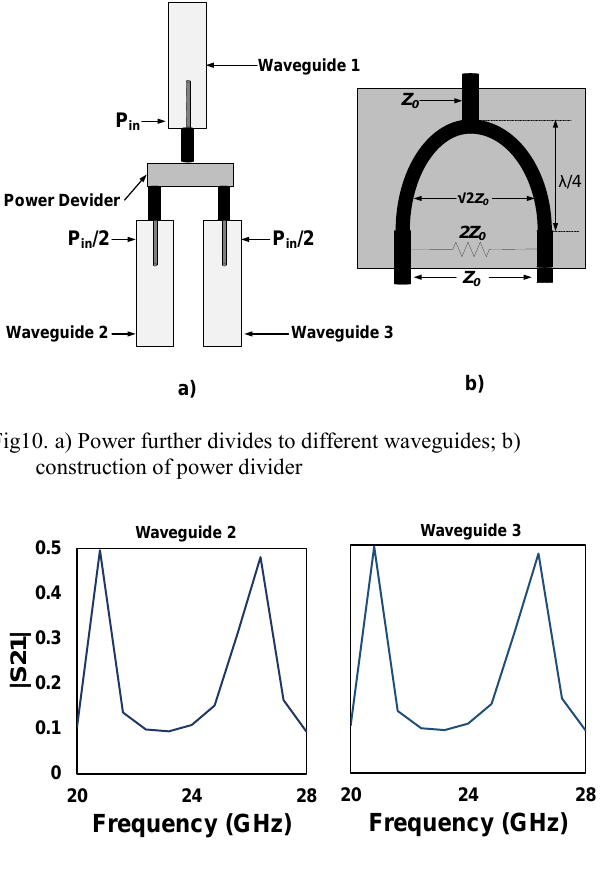
Fig11. Magnitude of transmission coefficient at each